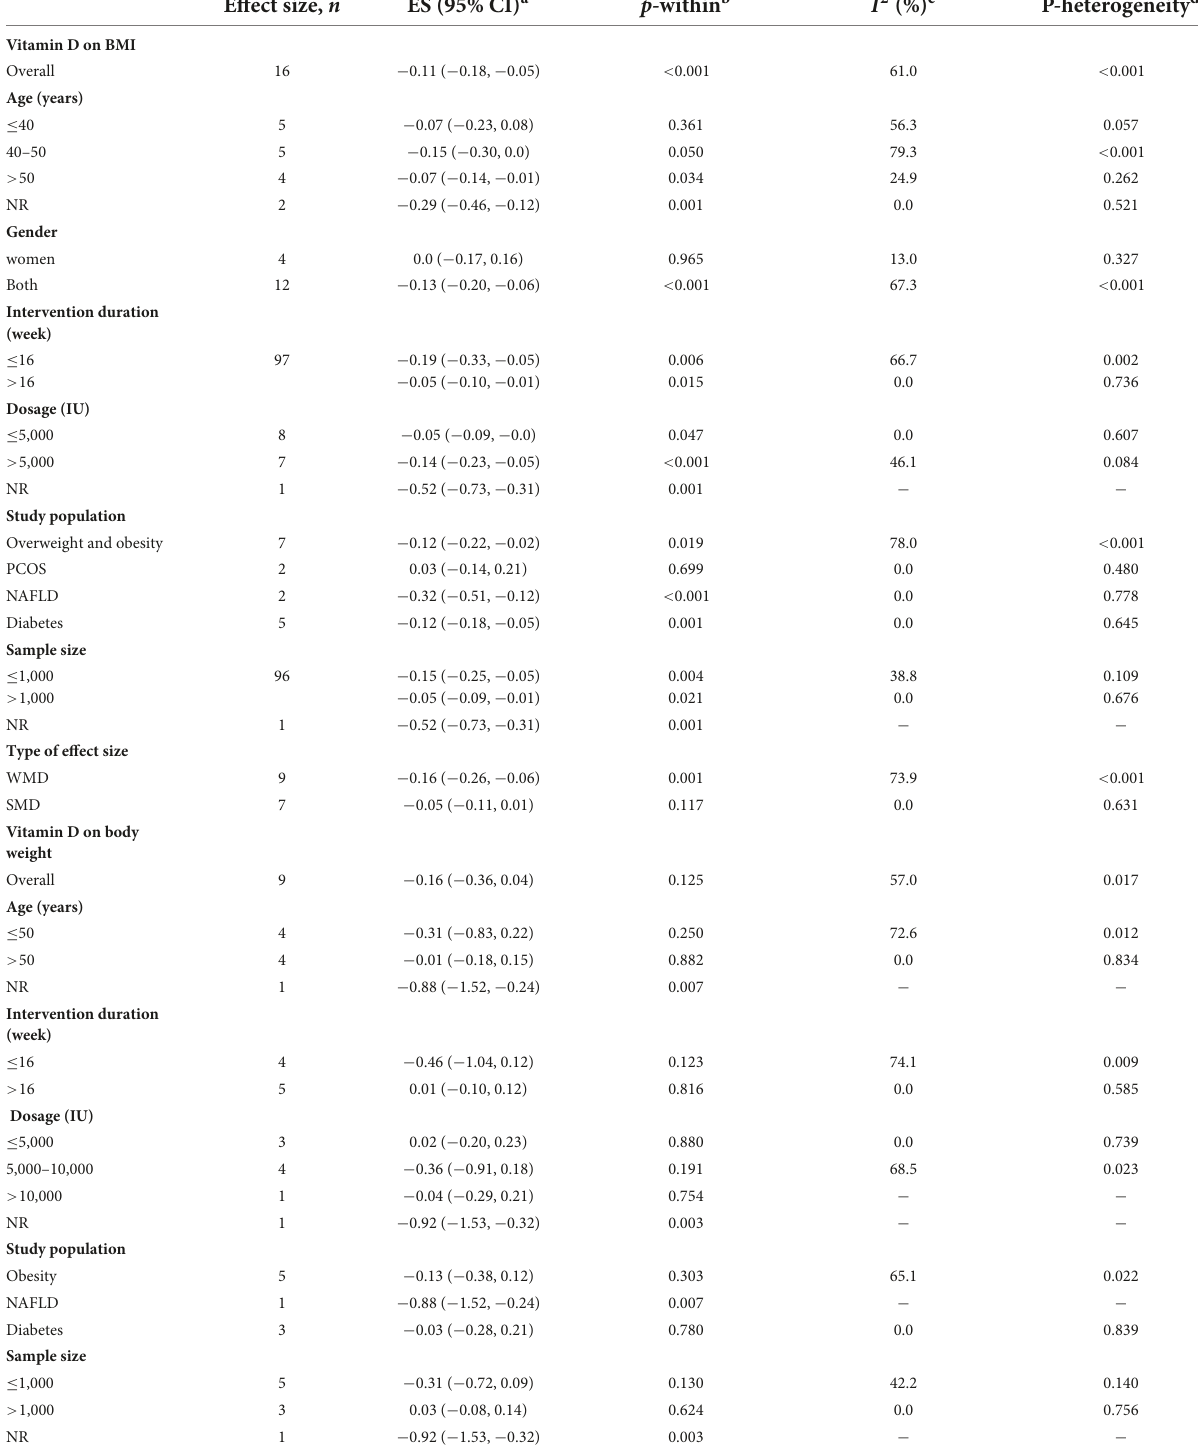
TABLE 4 Subgroup analyses for the effects of vitamin D supplementation on obesity indices. Effect size, n P-heterogeneity